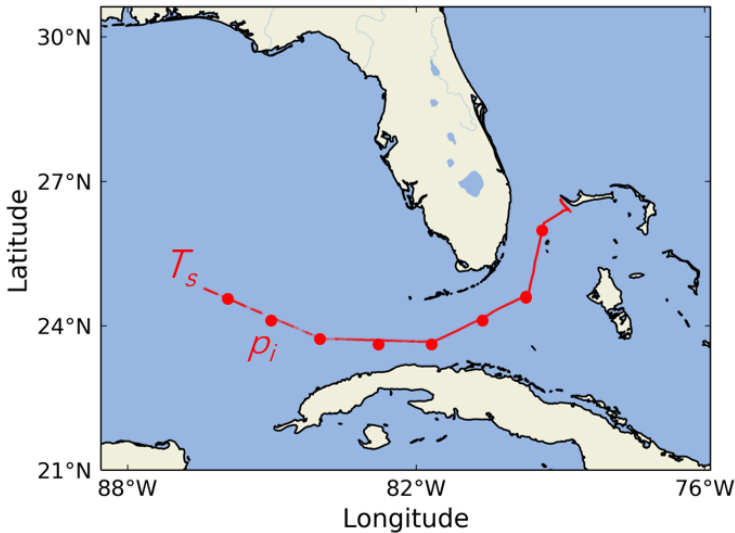
Figure 1. Schematic diagram of ship trajectory pattern.